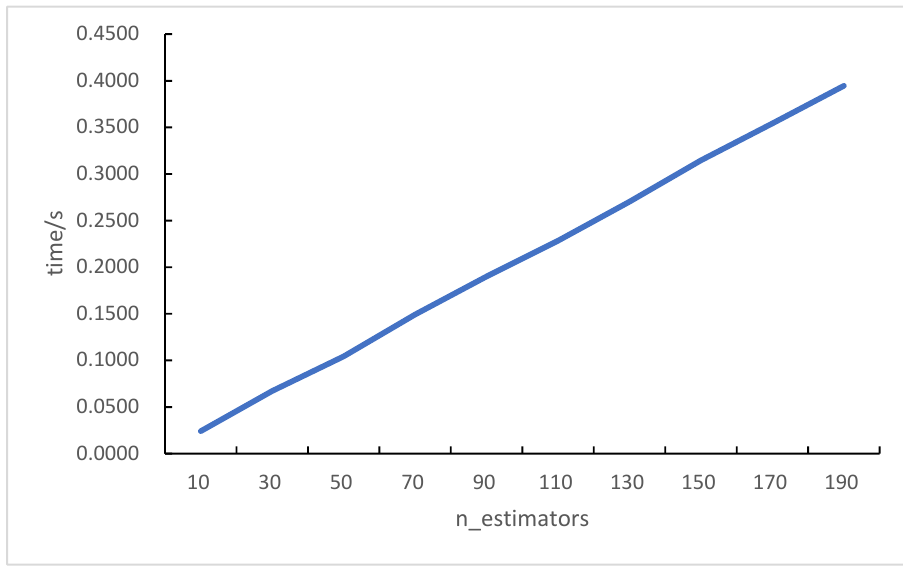
Figure 18. n_estimators optimizes predict_time.